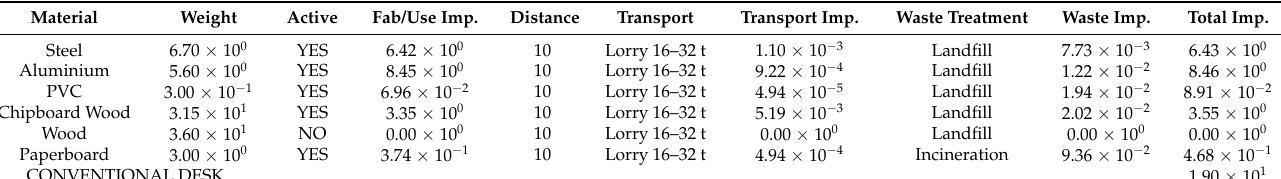
Table 8. Results of conventional desk scenario.